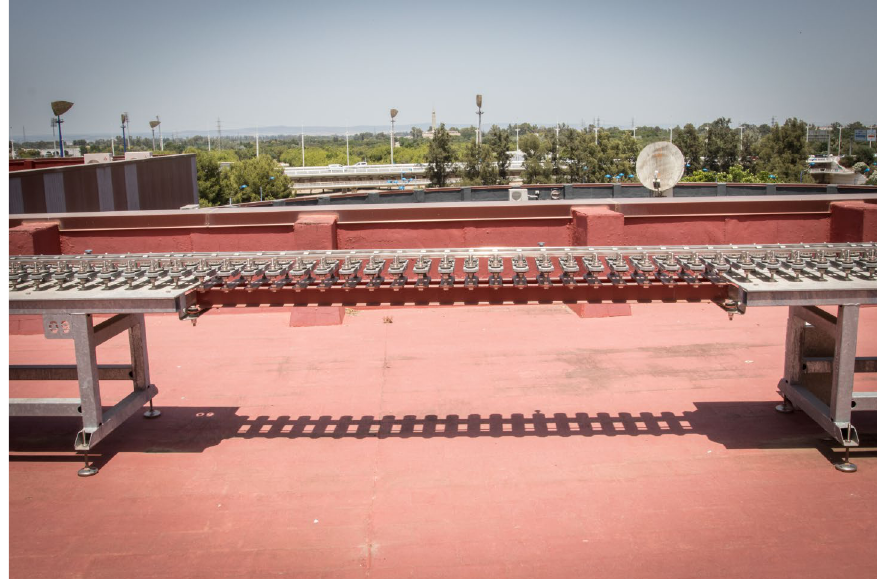
Figure 10. View of the 2m-length bridge. Photographer: Ludivine Mimar.